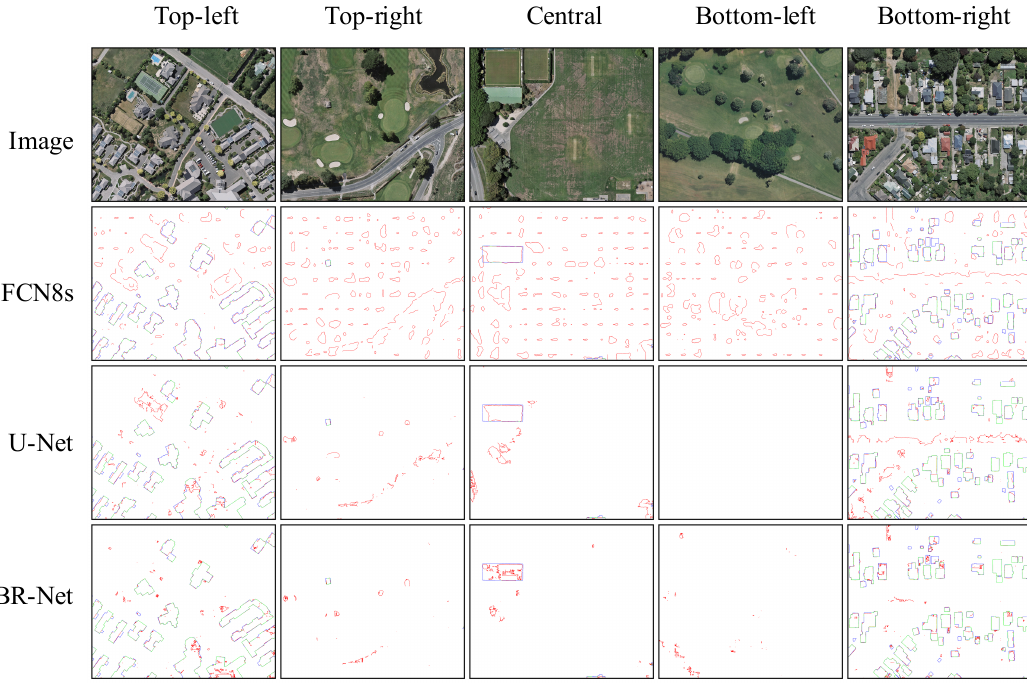
Figure 7. Results of outline extraction from different regions by FCN8s, U-Net, and the proposed BR-Net. The five regions are located in the top-left, top-right, central, bottom-left, and bottom-right portions of the testing area. Each region contains 2240 × 2240 pixels. The green, red, blue, and white channels in the results represent true positive, false positive, false negative, and true negative predictions, respectively.